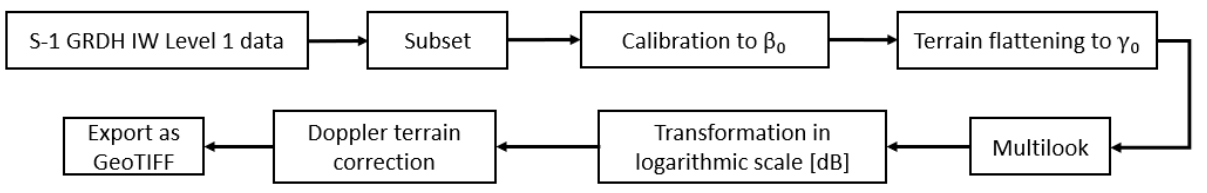
Figure 6. Sentinel-1 preprocessing workflow.